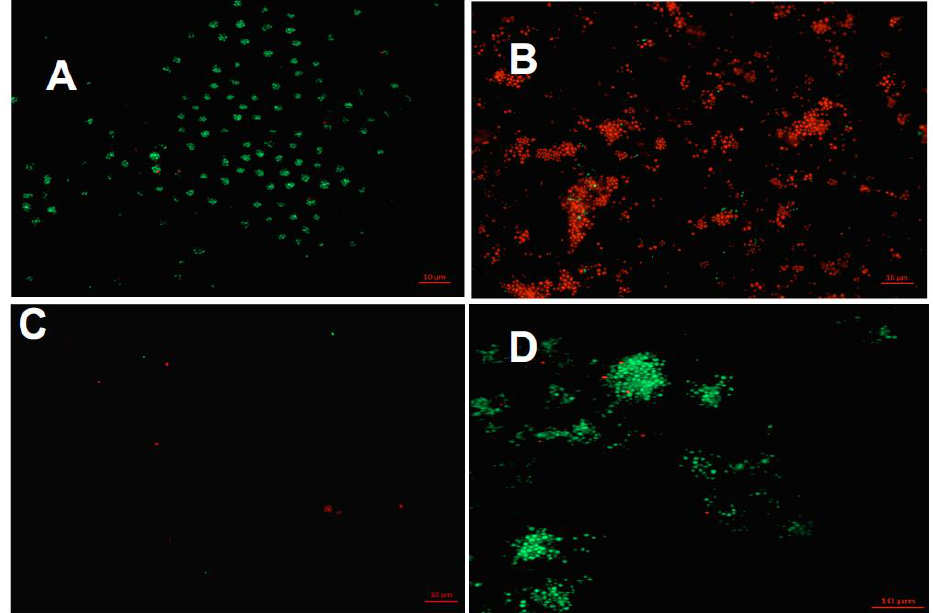
Figure 5. Fluorescence microscopy images after live/dead staining with BacLight ® . The vital (active) bacteria fluoresce in green, the avital (non-active) in red. The initial adhesion (2 h) is depicted on bovine dentin (control) ( A ), MTA (B), Biodentine ( C ), and AH Plus ( D